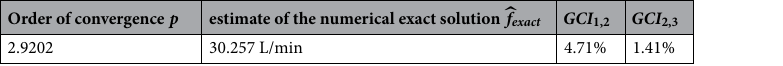
Table 5. Results of the grid convergence analysis.